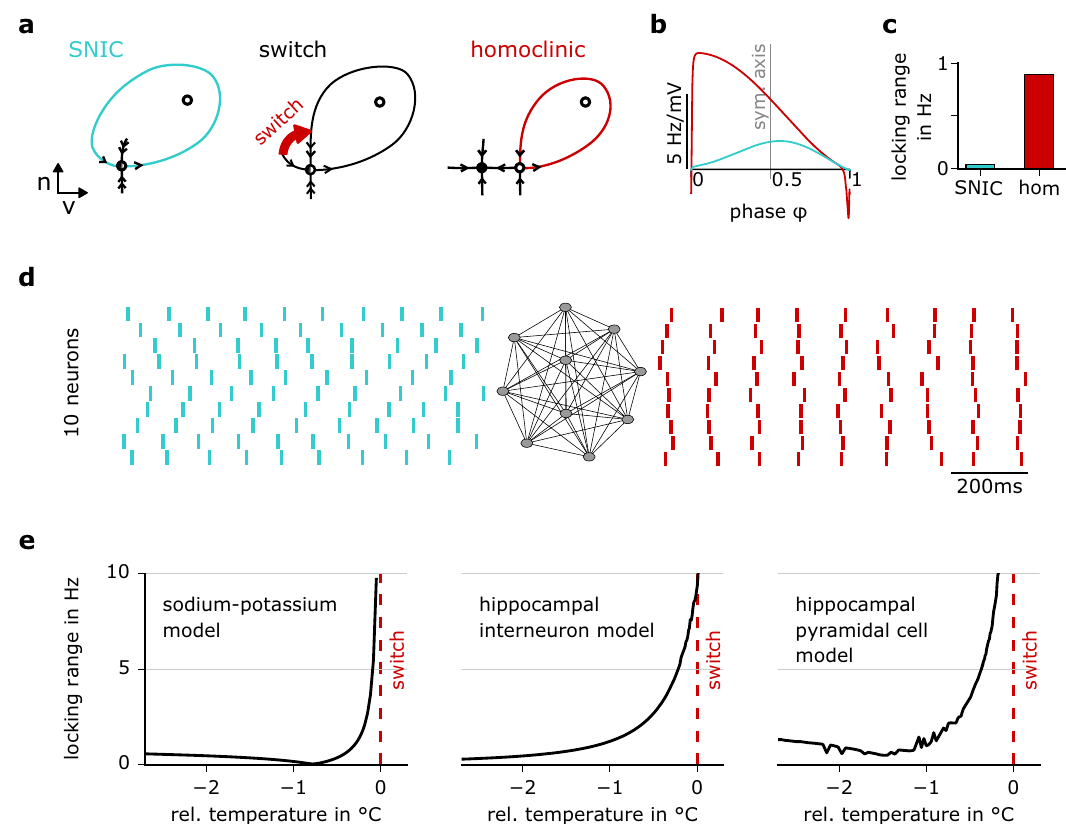
Fig. 2 Network synchronization depends on the type of cell-intrinsic dynamics. a Phase portraits of the saddle-node-on-invariant cycle (SNIC) and homoclinic dynamics illustrate the co-existence of a stable resting (full circle) and spiking attractor in the homoclinic case, once the limit cycle detaches from the saddle fi xed point (red homoclinic orbit in the right panel). b Phase-response curves (PRCs) of model neurons with a SNIC spike onset (blue), and a homoclinic spike onset (red). c The asymmetric PRC of the homoclinic neuron (compare b , red trace) results in a larger locking range than the symmetric PRC of the SNIC neuron (compare b , blue trace). d Spiking responses of a fully coupled inhibitory network of model neurons with SNIC (blue) or homoclinic (red) spike onset. Distinct network synchronization results entirely from differences in cell-intrinsic dynamics. e A temperature rise changes fi ring from SNIC to homoclinic in diverse conductance-based models. Locking range as a function of temperature (relative to the model ’ s critical transition temperature from SNIC to homoclinic